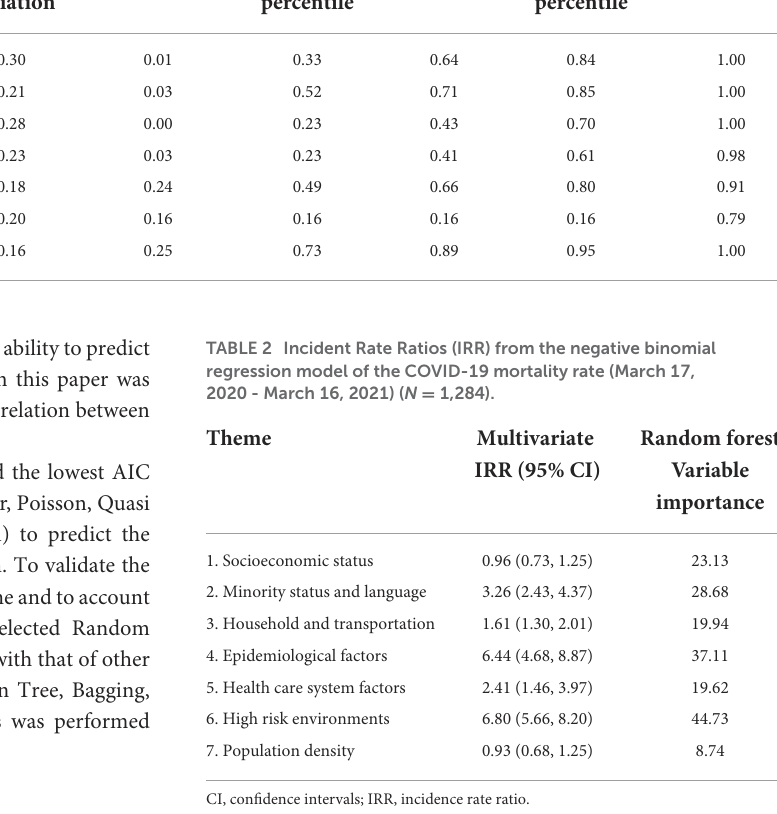
TABLE 1 Descriptive statistics for the COVID-19 Community Vulnerability Index (CCVI) for census tracts of Cook County ( N = 1,284). Theme Mean